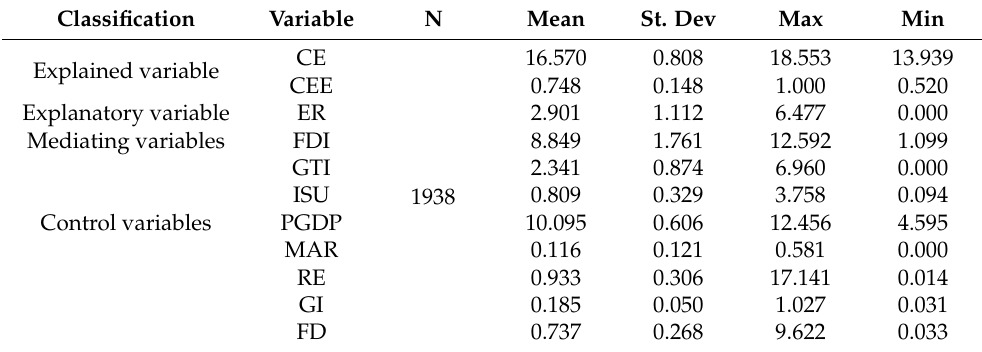
Table 3. Descriptive statistics of the